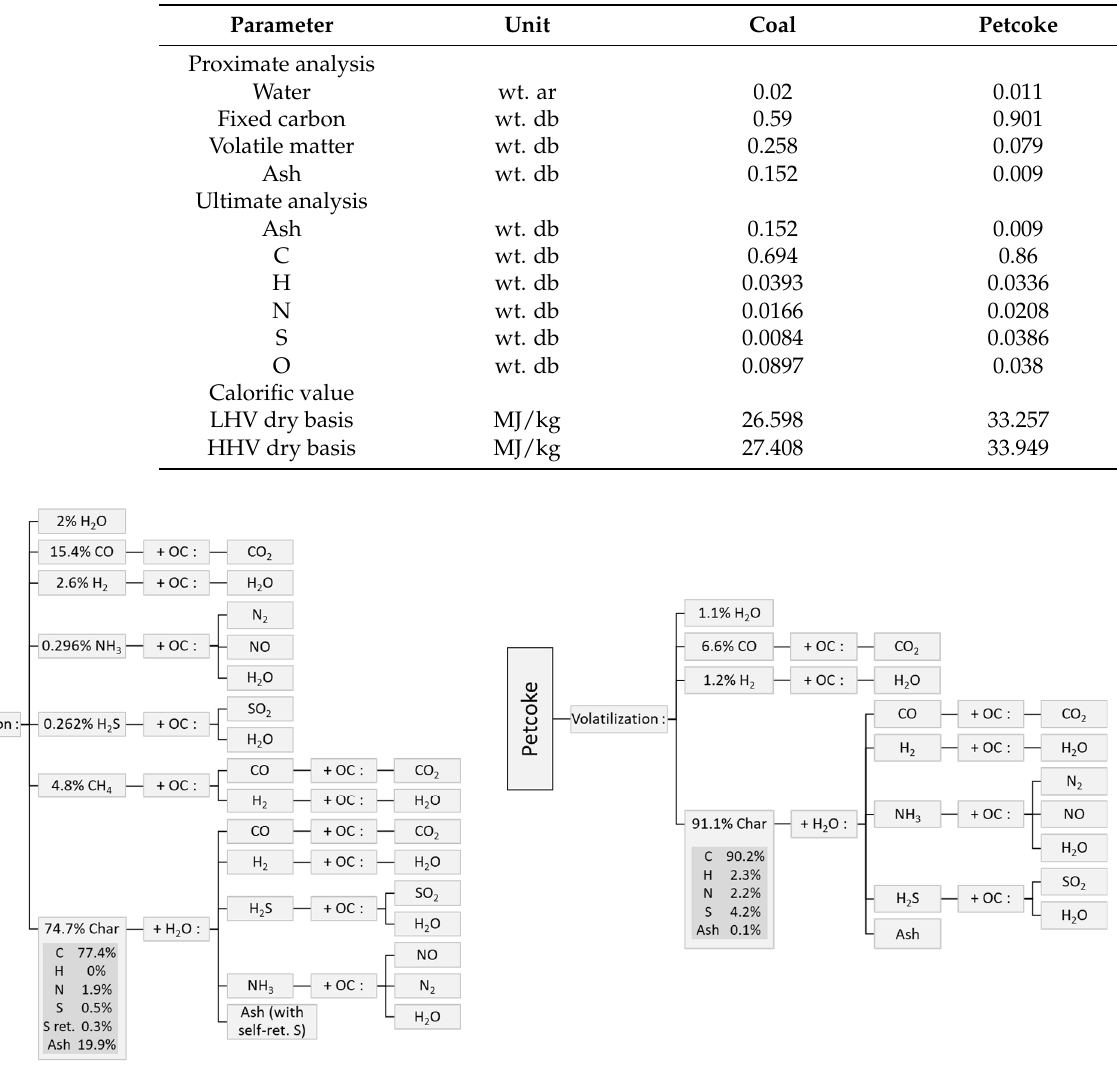
Table 2. Solid fuels’ characteristics. “wt.” means “mass fraction”, “ar” means “as received” (i.e., on a wet basis), and “db” means “on a dry basis”.